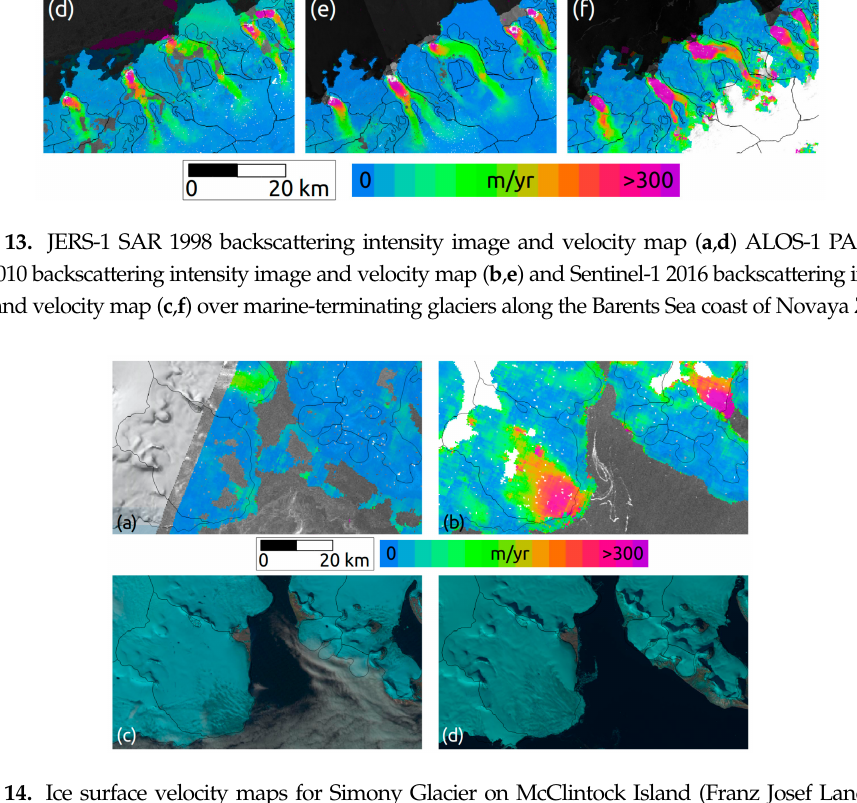
Figure 14. Ice surface velocity maps for Simony Glacier on McClintock Island (Franz Josef Land) from JERS-1 SAR data in 1998 ( a ) and Sentinel-1 in October 2015 ( b ) and satellite optical images from Landsat-4 on 22/07/2006 ( c ) and Landsat-8 on 27/08/2014 ( d ).